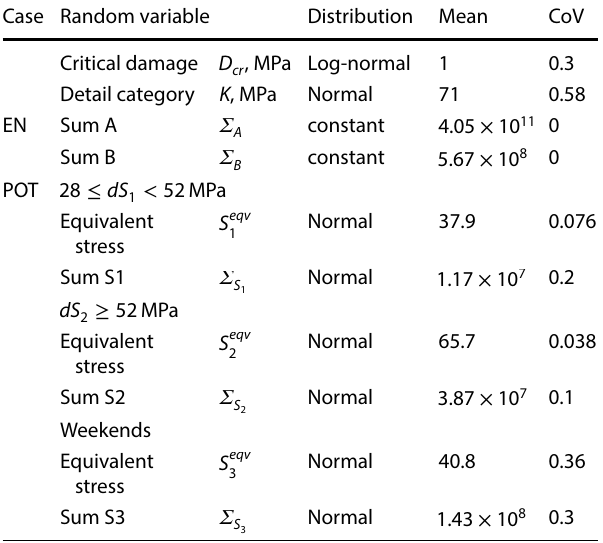
Table 3 Random variables for the fatigue reliability analysis Case Random variable